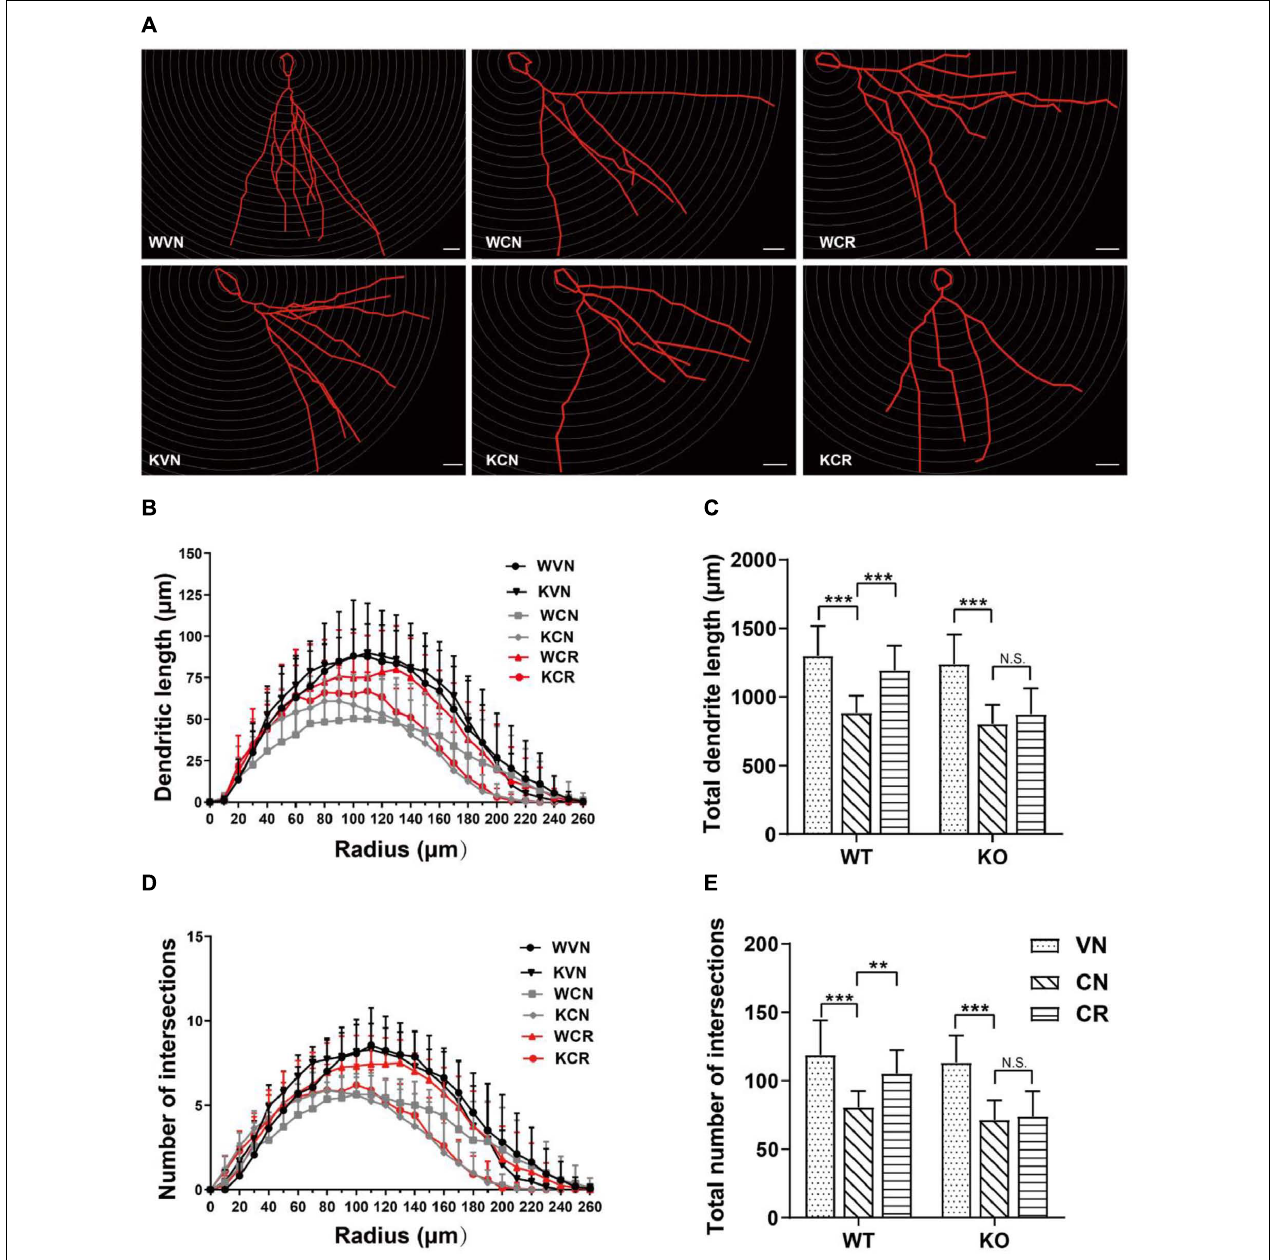
FIGURE 3 | Adiponectin is required for exercise to mitigate corticosterone-elicited impairment of dendritic reorganization. (A) The typical morphology of neurons was reconstructed with Neurolucida software. Scale bars: 20 µ m. (B,C) COR treatment remarkably decreased the dendritic length, as illustrated by the distribution plot of dendritic length ( B ; n = 12–17 neurons/group) and the average of total dendritic length ( C ; n = 12–17 neurons/group). (D–E) The number of intersections also declined after COR treatments by Sholl analysis, as evidenced by the distribution plot of the number of intersections ( D ; n = 12–17 neurons/group) and the average of total intersections ( E ; n = 12–17 neurons/group). Notably, exercise significantly increased the dendritic length and the number of intersections in WCR rather than KCR. Data are shown as means ± SD. ** p < 0.01, *** p < 0.001 by two-way ANOVA and Tukey’s post hoc test. N.S.,